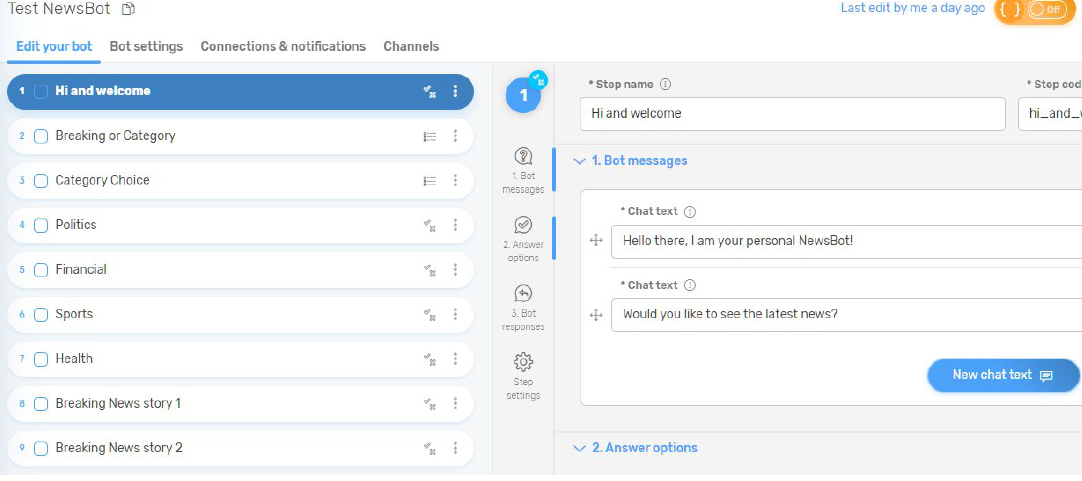
Figure 2. The chatbot creation interface of Quriobot. The “steps” can be seen on the left side. SnatchBot